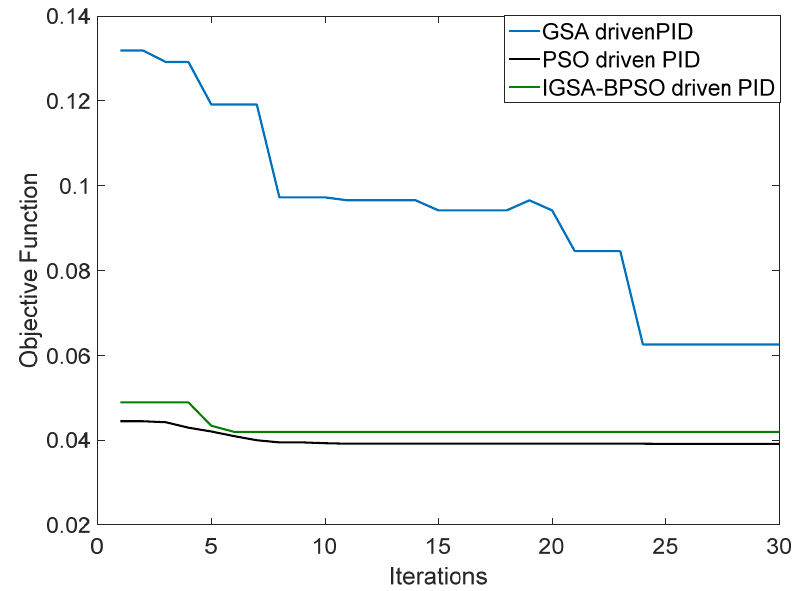
Figure 8. Convergence characteristics for different techniques.